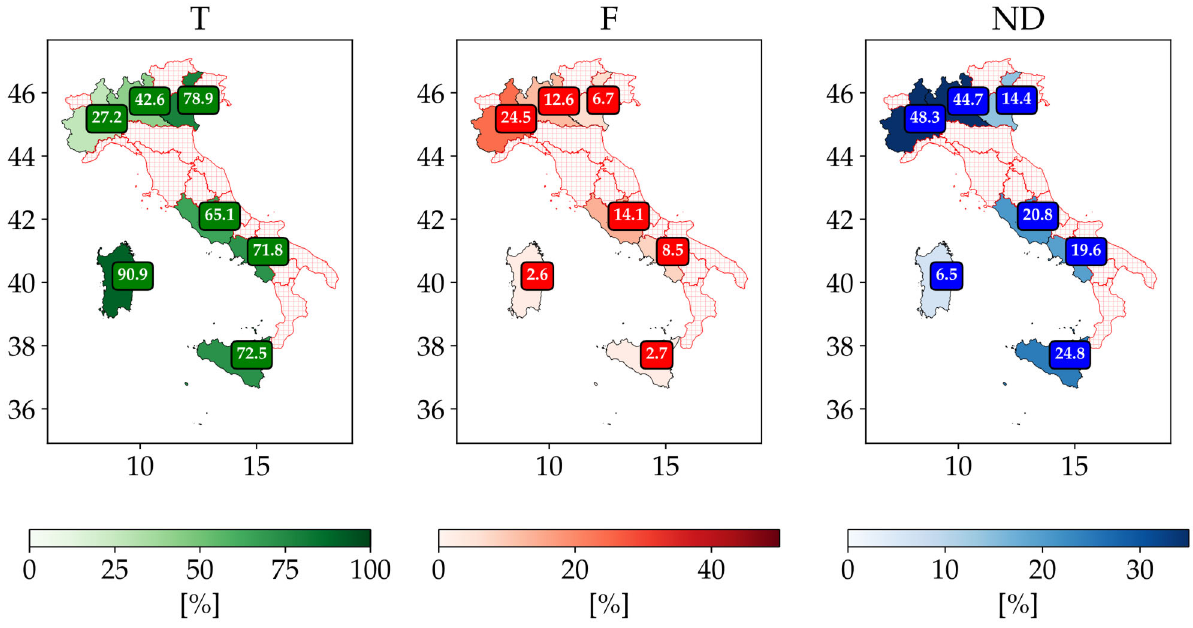
Figure 24. Regional Comparison of the classification labels rate by the 2nd Harmonic Criterion for the IN